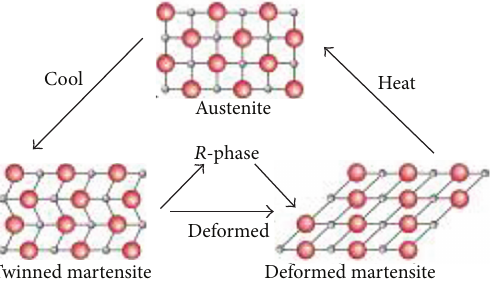
Figure1:Forceandtemperaturedependenttransitionsfromausten- ite to martensite, including the intermediary R -phase.